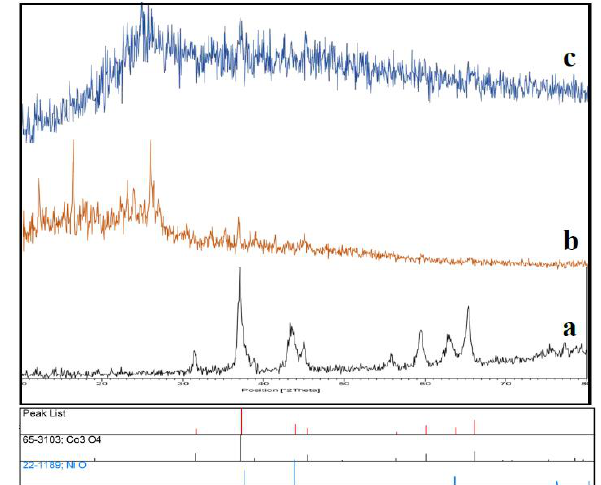
Fig. 1. XRD pattern of (a) Co Fig 1. XRD pattern of (a) Co 3 O 4 /NiO, (b) Co 3 O 4 /NiO@GQDs and (c) Co 3 O 4 /NiO@GQDs @ SO 3 H